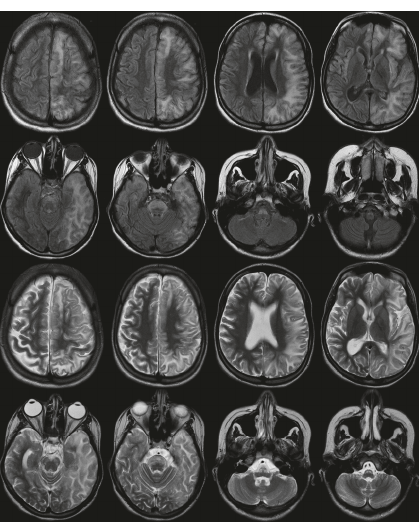
Figure 1: MRI of the brain showing evidence of diffuse asym- metrical, left more than right, cortical laminar necrosis secondary to refractory status epilepticus with anoxic brain damage. The images are FLAIR (upper two rows) and T2-weighted images (lower two rows). The changes are high signal intensity involving both supratentorial structures and brain